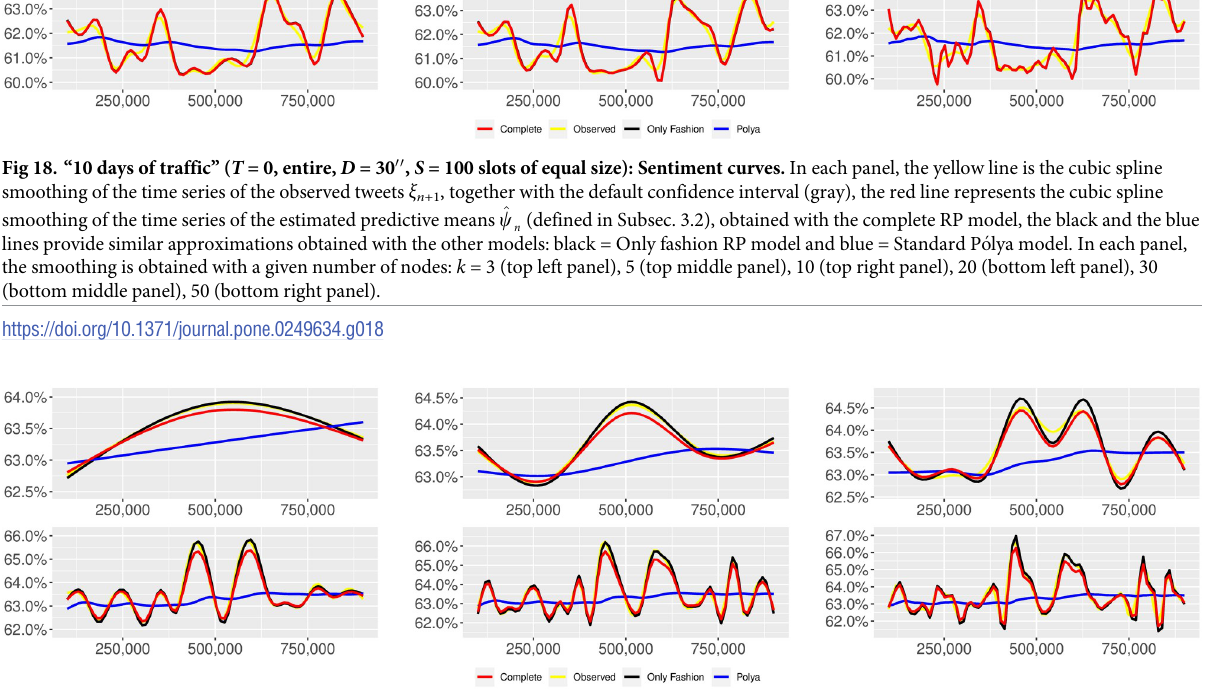
PLOS ONE | https://doi.org/10.1371/journal.pone.0249634 April 15, 2021 23 /